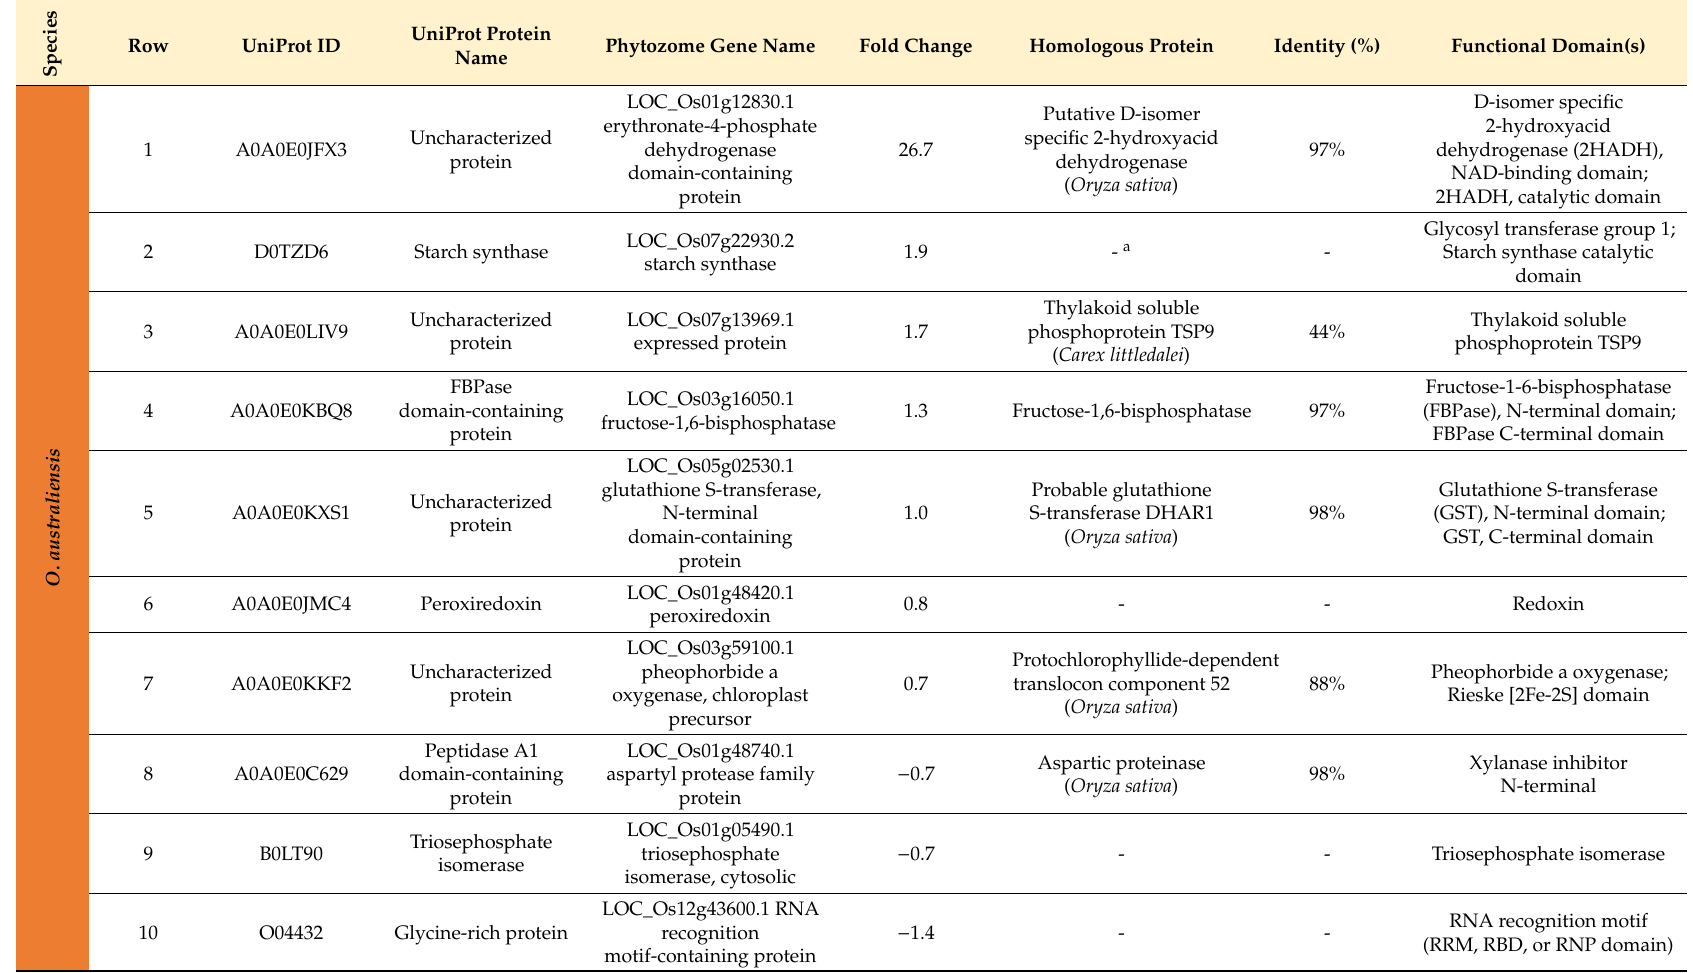
Table 4. Proteins with significantly altered accumulation levels in response to drought stress which were uniquely identified in one